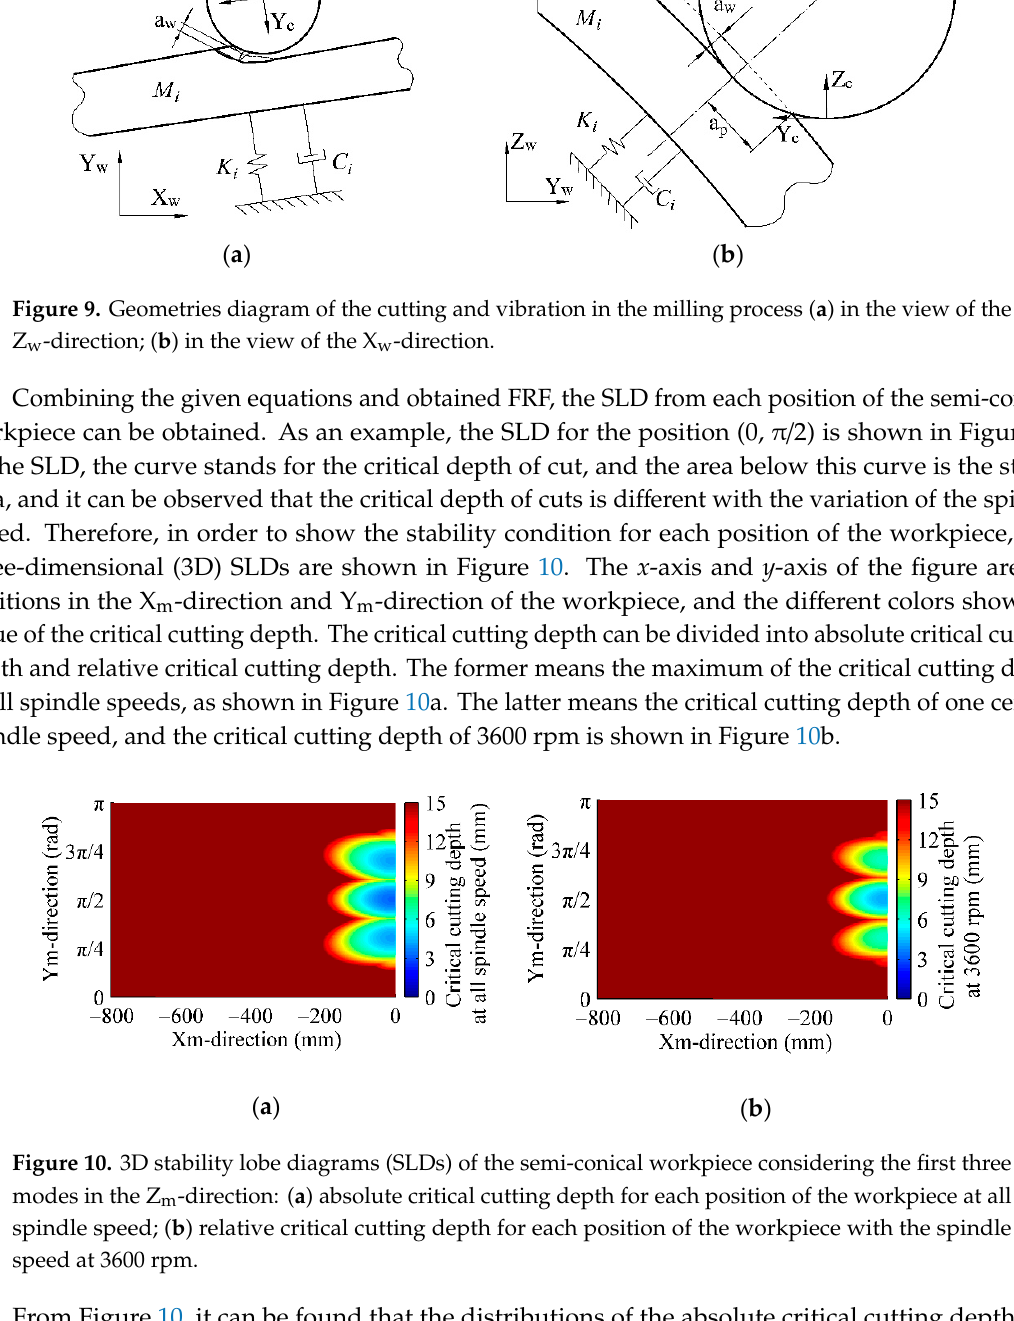
( c ) Figure 8. ( a ) Magnitude of the frequency response function (FRF) from the simulation and experiment; ( b ) real part of the FRF from the simulation and experiment; ( c ) stability lobe diagram obtained with the FRF from the simulation and experiment. The machining instability is the severe vibration in the machining process due to the weak rigidity of the tool or workpiece, which is also known as the chatter phenomenon. The regenerative effect is the principal factor of the chatter, and the stability lobe diagram (SLD) is an important and effective tool to show the relationship between machining stability and machining parameters. Based on the Fourier series approach, the method proposed by Altintas [45,46] has been widely used in practical conditions and embedded into much commercial software. However, a more simple and